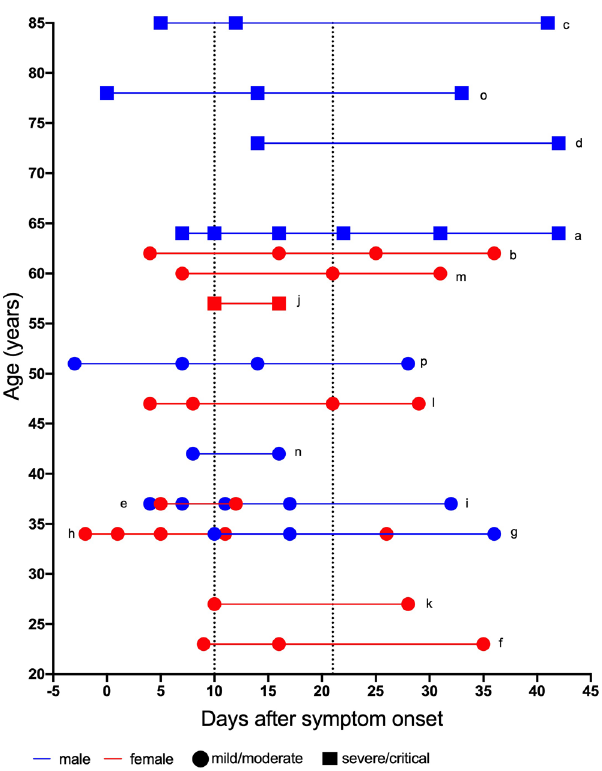
Fig. 1 Patient and sample characteristics of the 1 st cohort. Characteristics (age, sex) of individuals included in this study and timepoints of sample collection after symptom onset. Letters a – p indicate the individual patients. Male patients are depicted in blue, female patients in red. Circles represent samples of mild or moderate (MM) patients, squares those of critical or severe (CS) patients. Acute phase: 14 MM and 3 CS samples; intermediate phase: 13 MM and 7 CS samples; late phase: 10 and 6 samples. Dotted vertical lines indicate 10 days and 21 days after onset of